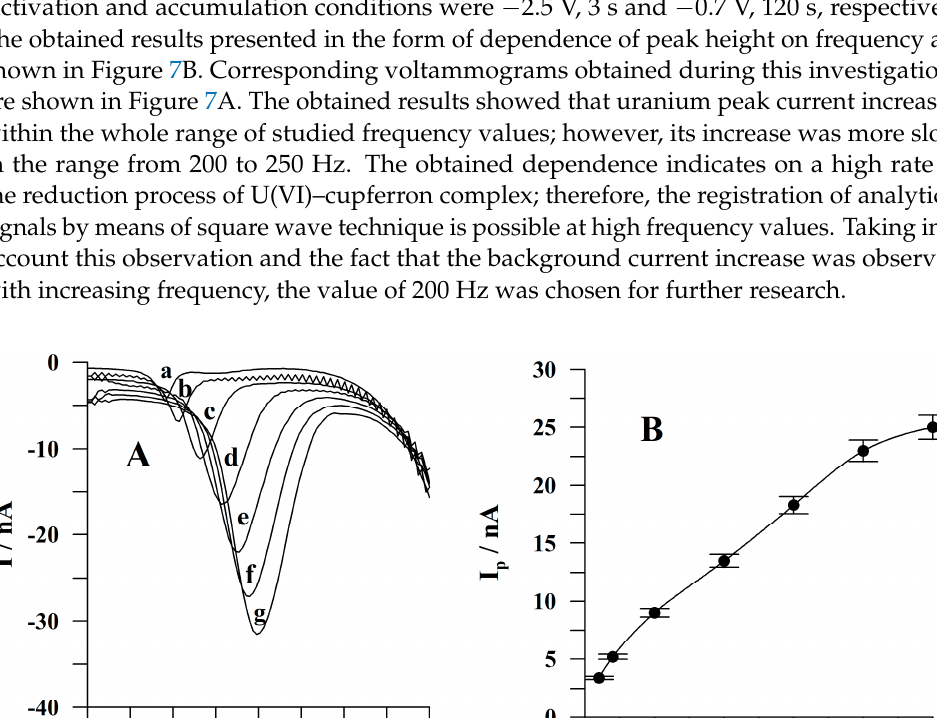
Figure 7. ( A ) The square wave uranium voltammograms obtained at various frequency values: (a) 10; (b) 20; (c) 50; (d) 100; (e) 150; (f) 200; (g) 250 Hz; ( B ) A dependence of U(VI) peak current on the frequency. U(VI) concentration: 1 × 10 − 7 mol L − 1 . Accumulation conditions: − 0.7 V, 120 s. The error bars refer to the standard deviation (n =